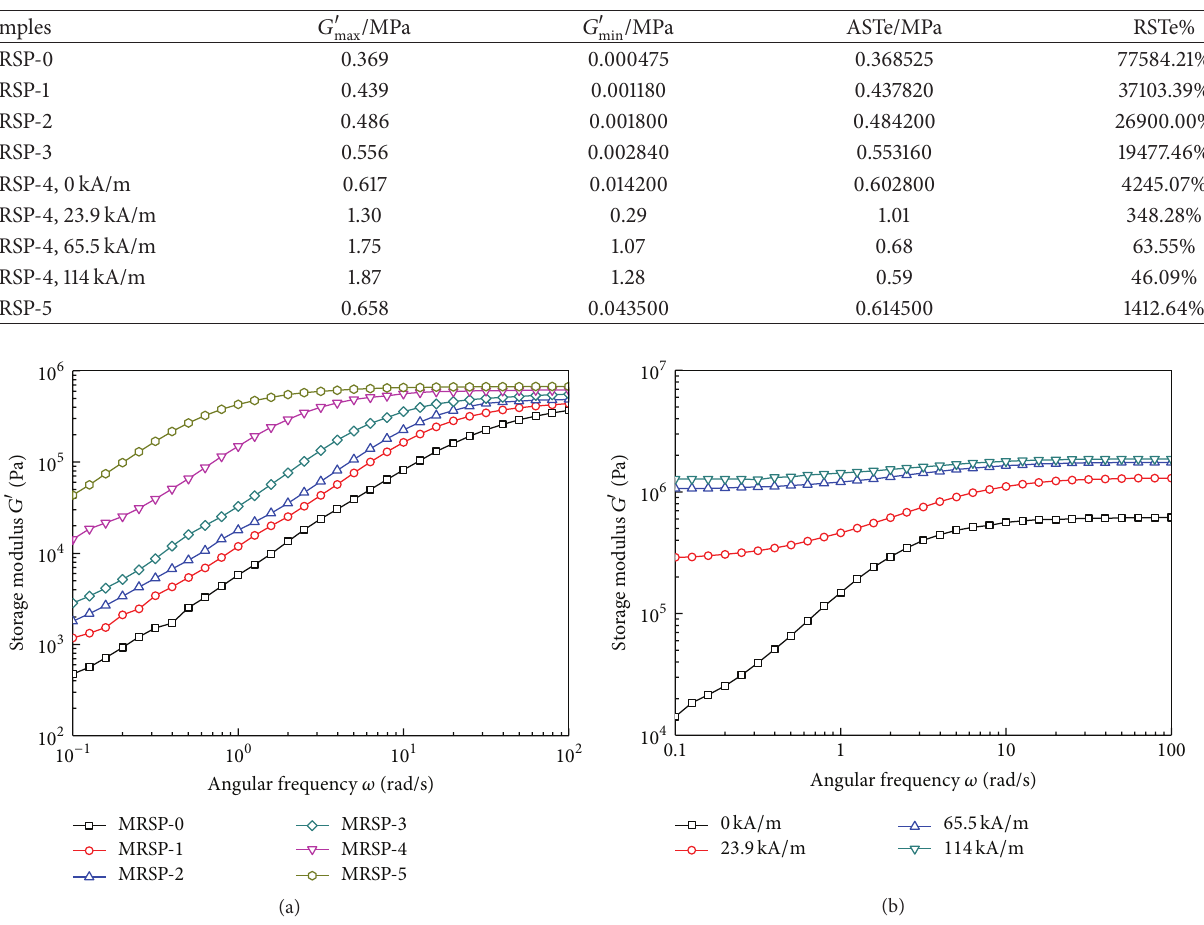
Table 3: 𝐺 󸀠 max , 𝐺 󸀠 min , ASTe, and RSTe% of MRSPs obtained from Figure 6.